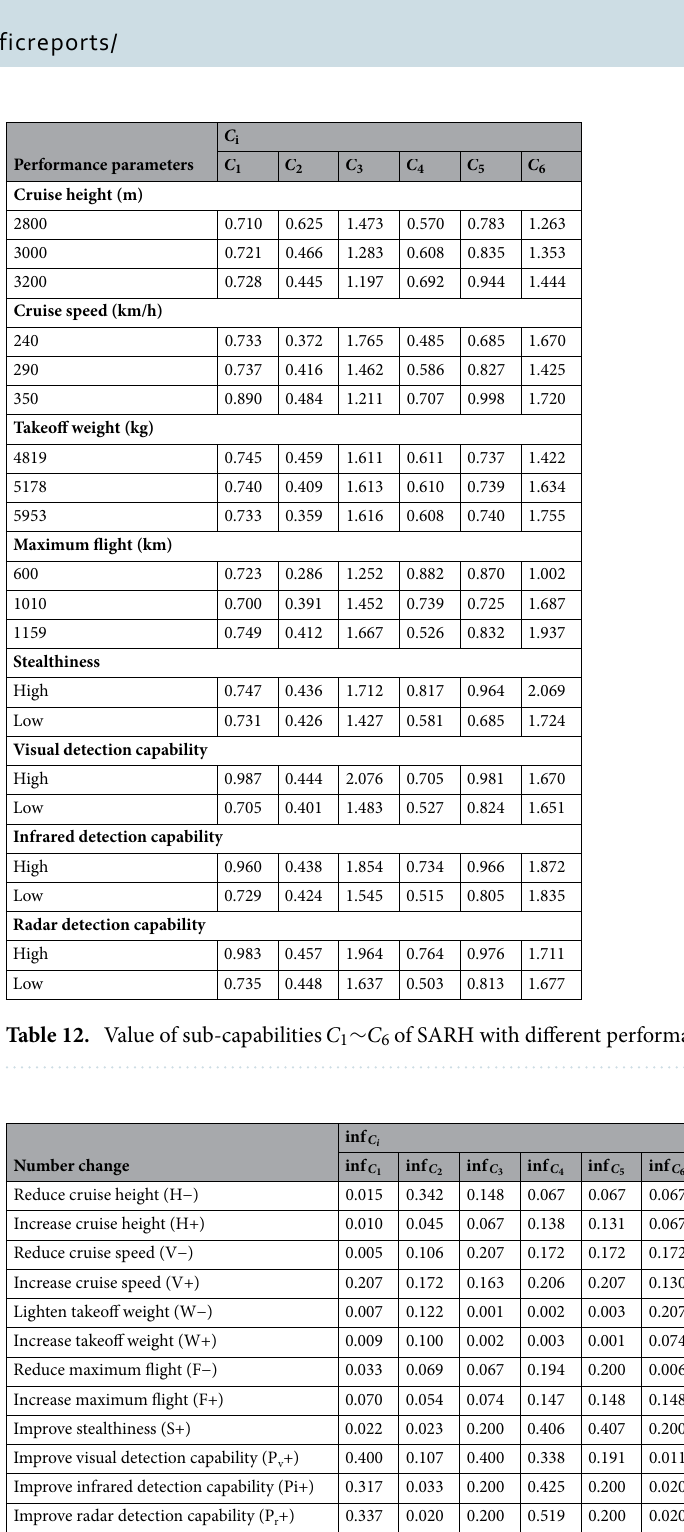
Table 13. Influence degree value of each sub-capability and entire SoS when changing the performance parameters of SARH.